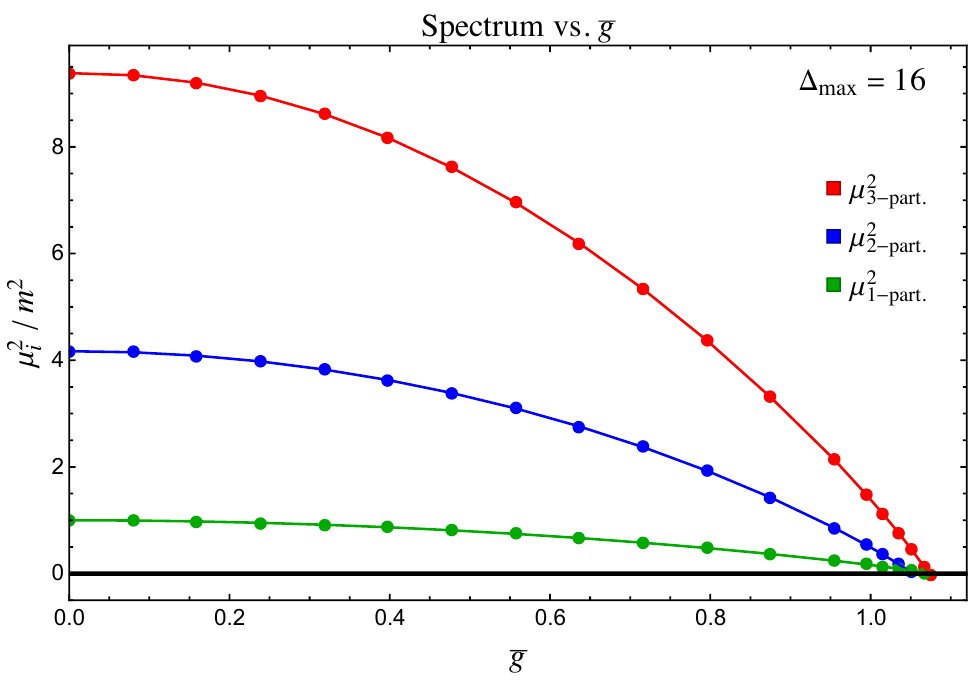
at ∆ = 16 , with ˆ c = 1 max L 4 πm